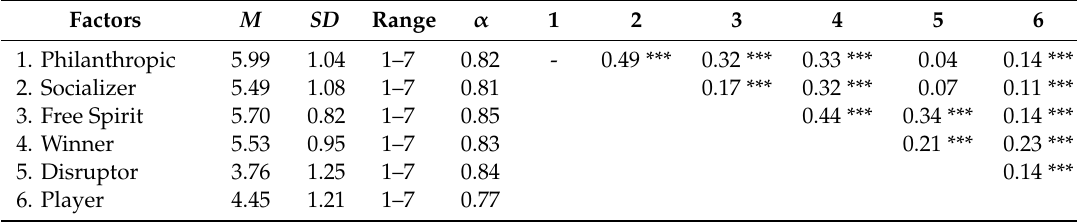
Table 2. Descriptive statistics, reliability analysis, and bivariate